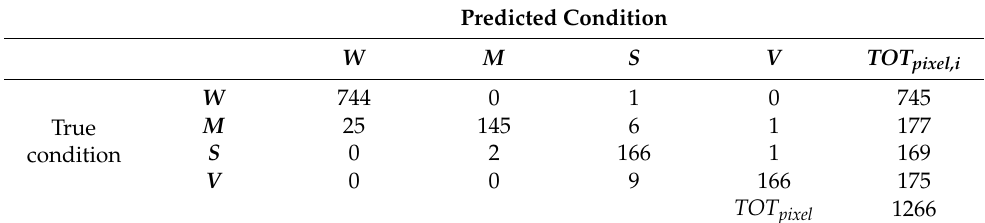
Table 6. Confusion matrix between predicted L8 classification and ground truth.